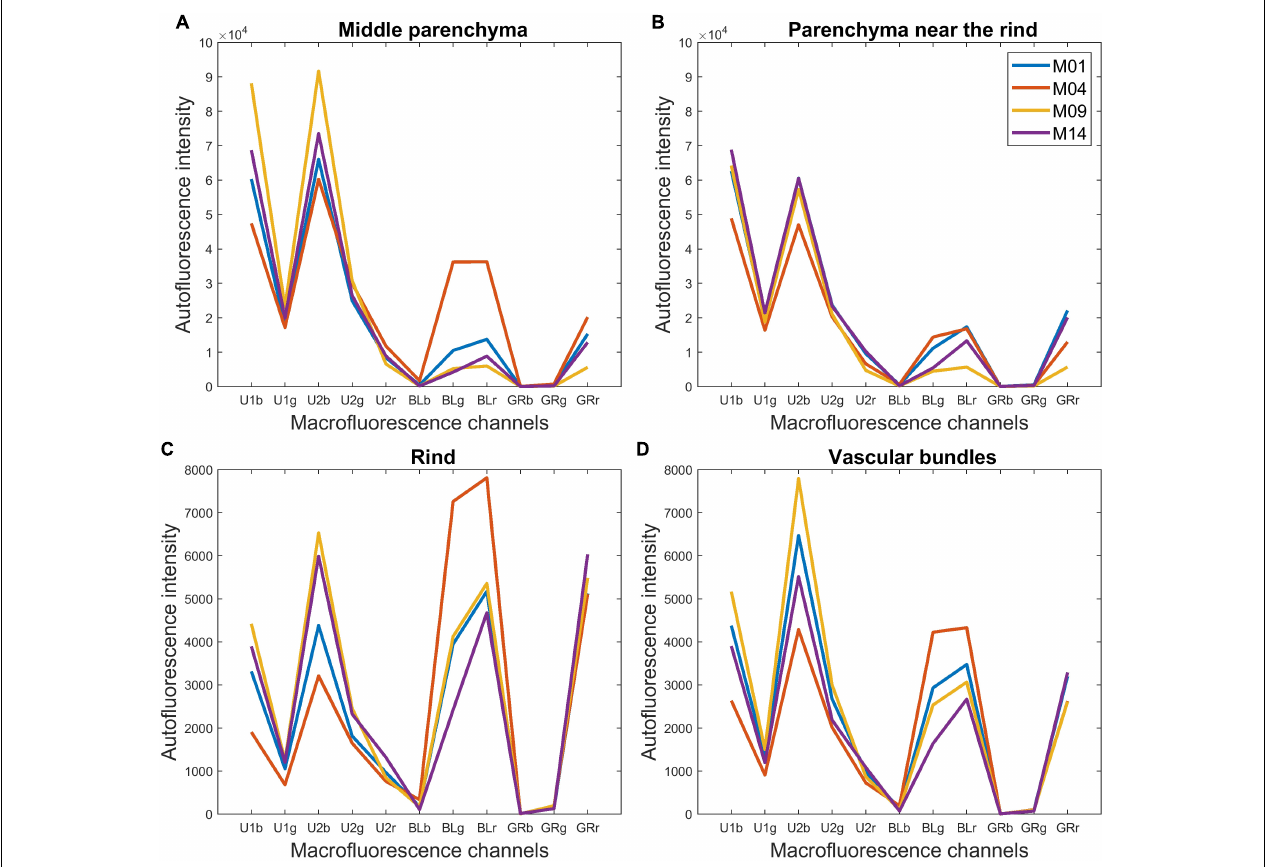
FIGURE 7 | Macrofluorescence analysis. Tissue-normalised pseudospectra of the four examples of inbred lines: (A) middle parenchyma, (B) parenchyma near the rind, (C) rind and (D) vascular bundles. The pseudospectra represent the average spectral fluorescence behaviour computed over all pixels of the considered region of interest. The first five values report the intensity of UV-induced fluorescence, and the six others report the intensity of visible-induced fluorescence. The pseudospectra were normalised and only relative intensity variations can be